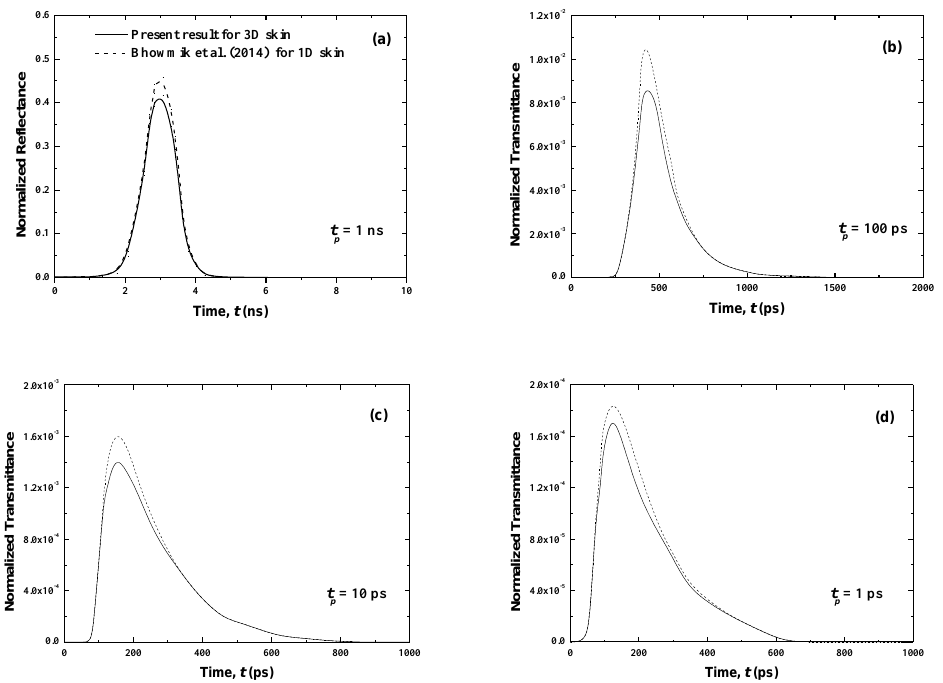
Figure 4. Temporal signals of normalized transmittance from the normal skin subjected to the laser pulse at different pulse widths of ( a ) t p = 1 ns, ( b ) t p = 100 ps, ( c ) t p = 10 ps and, (d) t p = 1 ps.